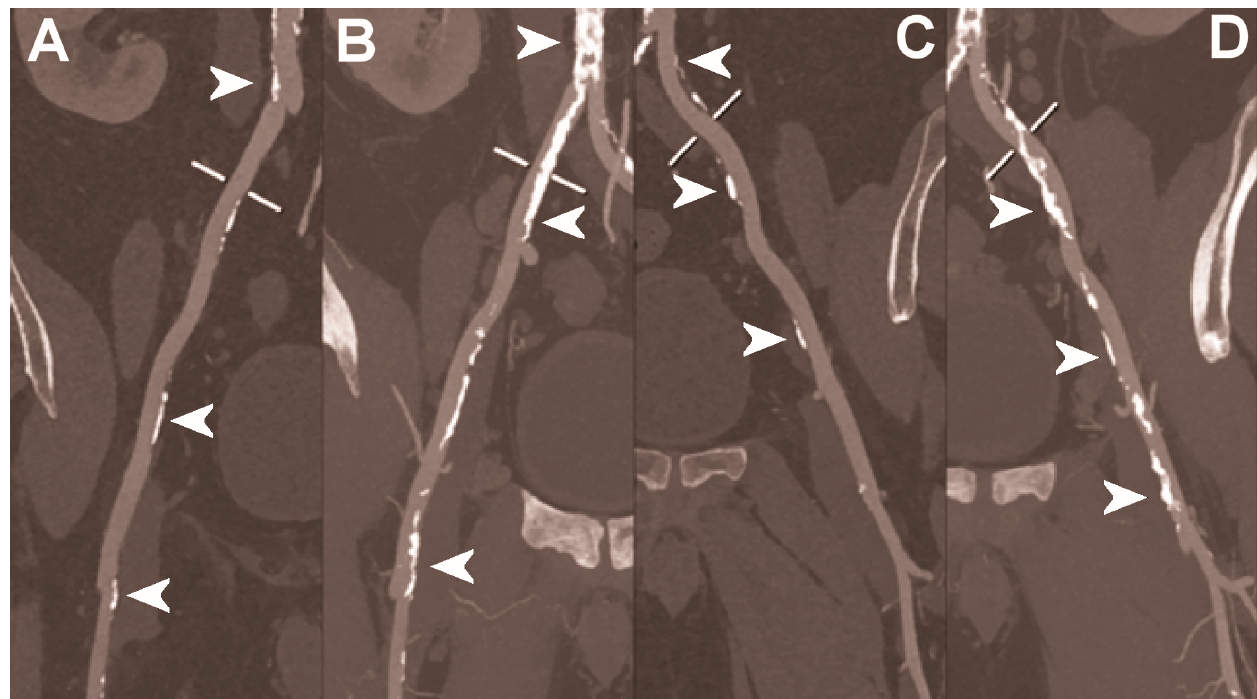
Figure 6. Abdominal CT angiography using photon-counting computed tomography. The figure shows advanced multiplanar reconstructions without and with MIP algorithm of a distal abdominal aorta and ilio-femoral arterial axes derived from a photon-counting CT (Scanner: NAEOTOM Alpha, Siemens) acquisition ( A , B right; C , D left). The projection start in the abdominal aorta carrefour and end in the right/left common femoral artery. There are massive calcifications along the common iliac arteries; however, both MPRs ( A , C ) and MIPs ( B , D ) are so sharply defining the edges of the structures that lumen assessment is not compromised (arrowheads).